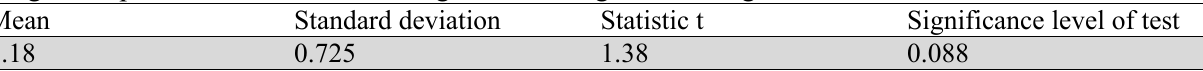
Single sample T test results to investigate achieving economic goals Mean